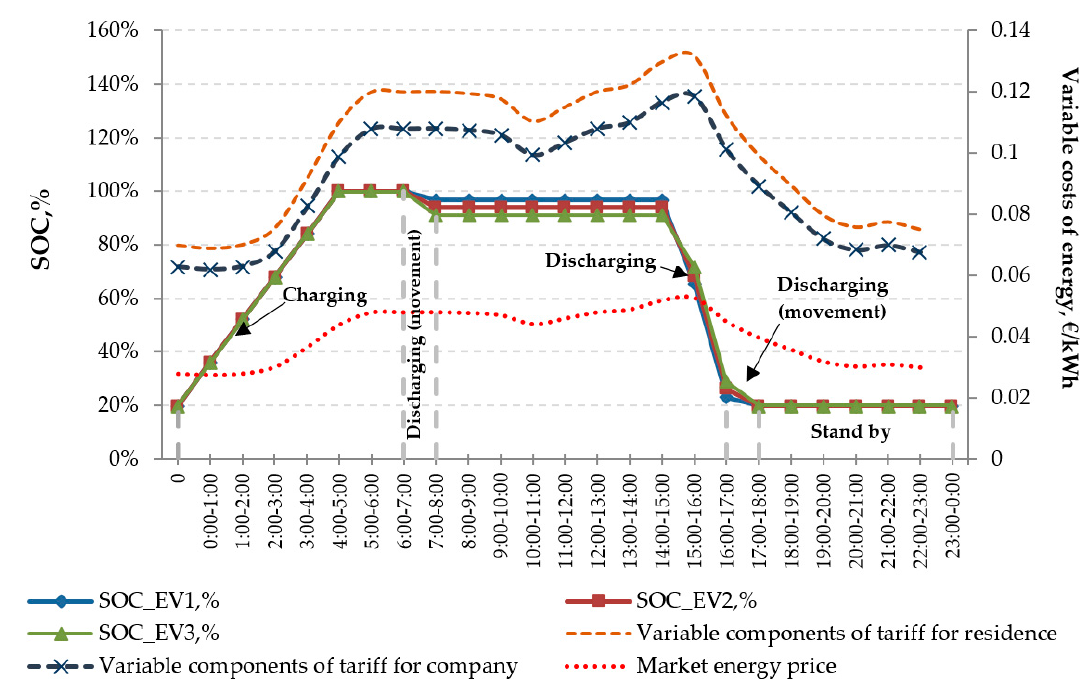
Figure 6. EV’s charging/ discharging profile (6 January 2018), applying the new billing system. Changes in the rules for creating an account led to a reduction in the prices at night (Figure 5), as a result of which the cost of battery charge was significantly reduced. At the same time, the prices rose during the peak hours. The changes in the prices have caused significant changes in the optimal battery discharge schedule (let us compare Figures 5–7).